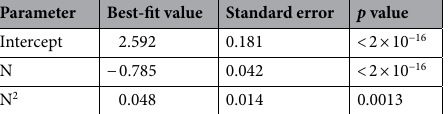
Table 3. Best-fit parameter values for the preferred dose reconstruction model using mouse qRT-PCR data.